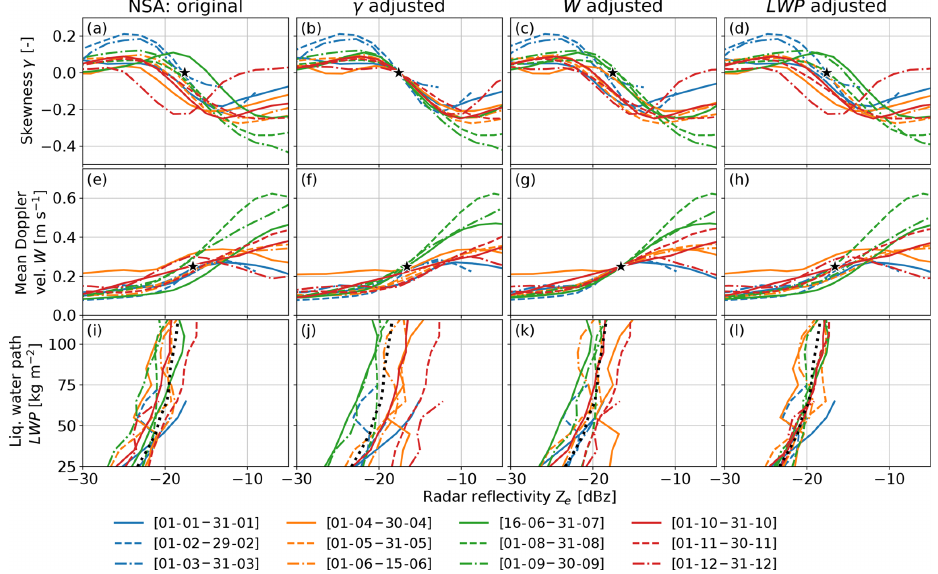
Figure 5. Observed reflectivity Z e – skewness γ (a) , Z e – mean Doppler velocity W (e) , and liquid water path LWP–max (Z e ) (i) relationships for the North Slope of Alaska (NSA). The data have been calibration-corrected using the γ method (second column), the W method (third column), and the LWP method (fourth column). The colored lines indicate the various calibration periods of 2016. The black stars (rows 1 and 2) show the reference point used for calibration; the dotted black line (row 3) is the reference LWP–max (Z e ) relationship obtained from the mean of the monthly relationships weighted by the number of observations.